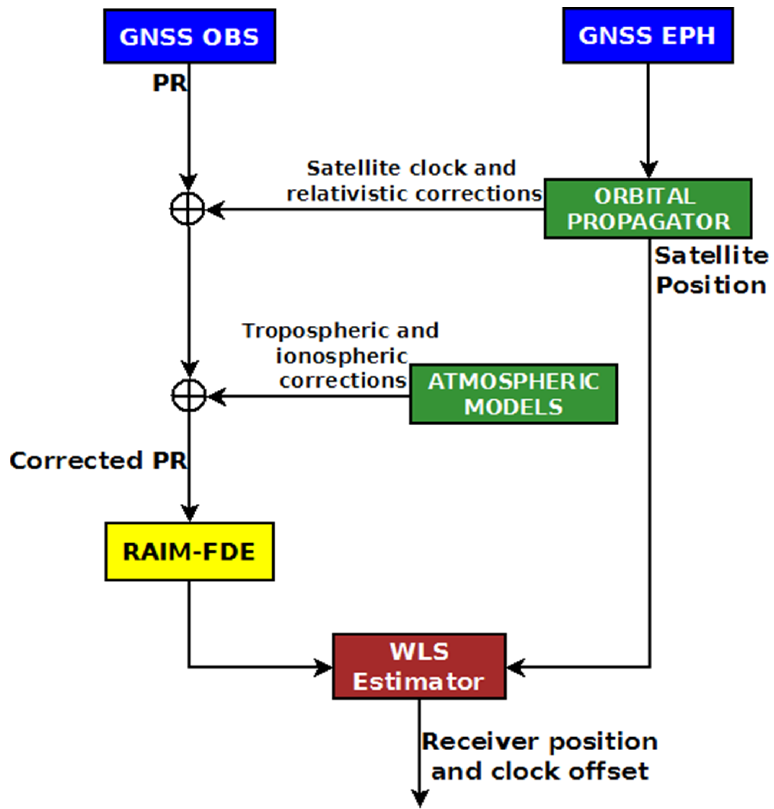
Figure 1. Scheme of absolute positioning with pseudorange measurements (adapted from [15]).